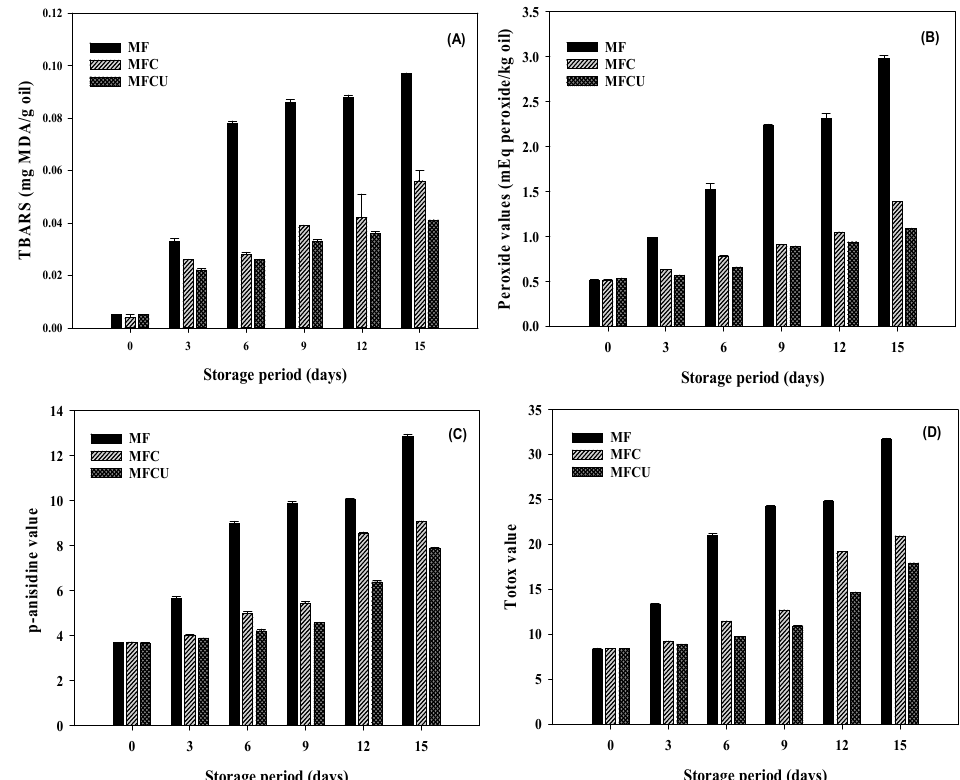
Figure 3. Lipid oxidation (TBARS ( A ), Peroxide value ( B ), p-anisidine value ( C ) and Totox value ( D )) inhibition by mung bean flour-based films processed under different conditions. Note: TBARS represents Thiobarbituric acid reactive substances.